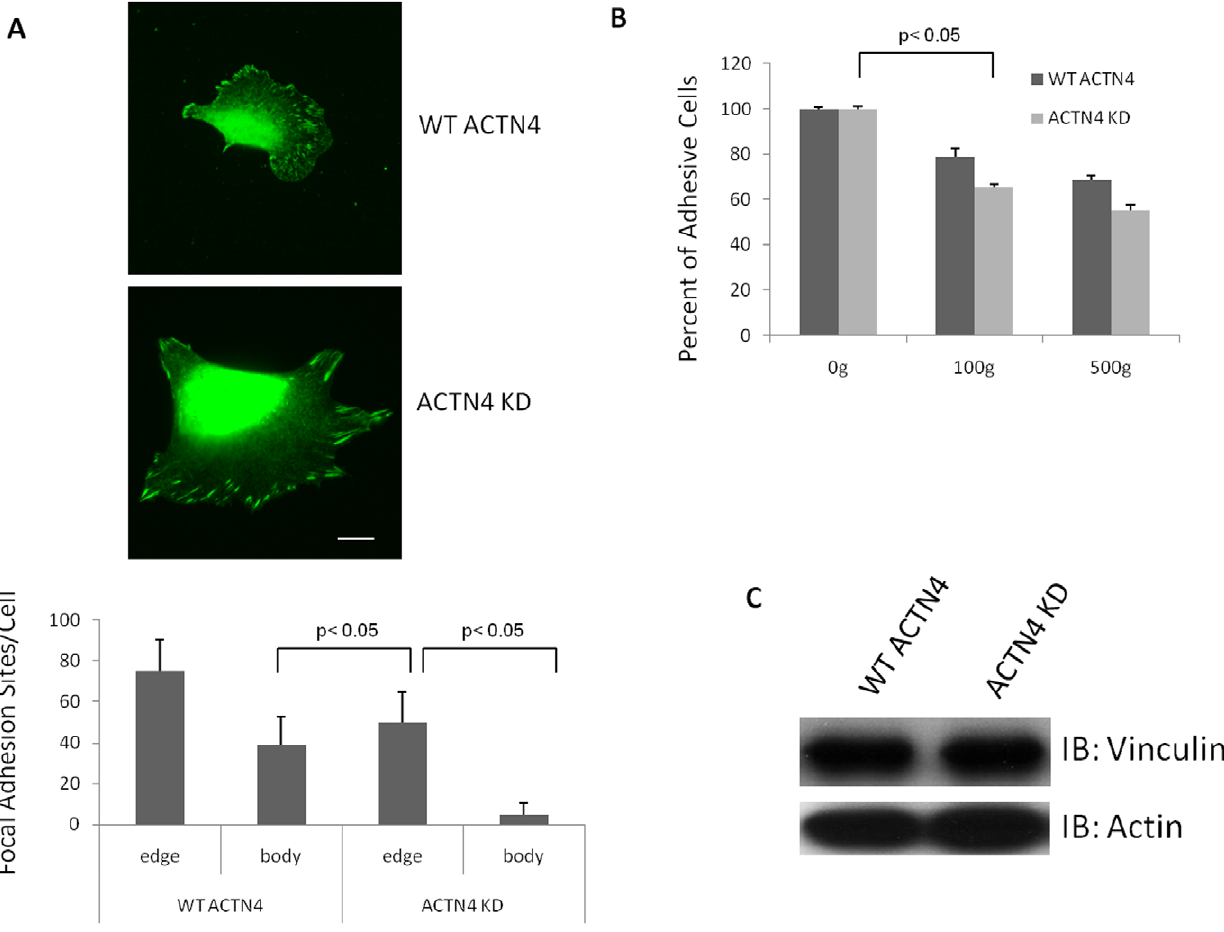
Figure 3. Knockdown of ACTN4 limits the number of focal adhesions. (A) WT ACTN4 and ACTN4 KD murine lung fibroblasts were stained for vinculin aggregates as indicative of focal adhesions. The number of focal adhesion sites residing within cell body and cellular edge were calculated by using ImageJ software for at least 30 individual cells. The ratio of focal adhesion sites between cell body and edge was also calculated. Images were taken randomly. Quantification was measured from at least 30 individual cells ( 6 the standard deviation) chosen randomly. Shown are representative of at least independent experiments. Bar =10 m m. (B) An inverted centrifugation focal adhesion assay was performed (see ‘‘material and method’’ for details). Data are mean 6 s.e.m., measured from three independent experiments. (C) Immunoblotting shows that the vinculin level was similar in WT and KD cells. Blot is representative of three independent assessments.